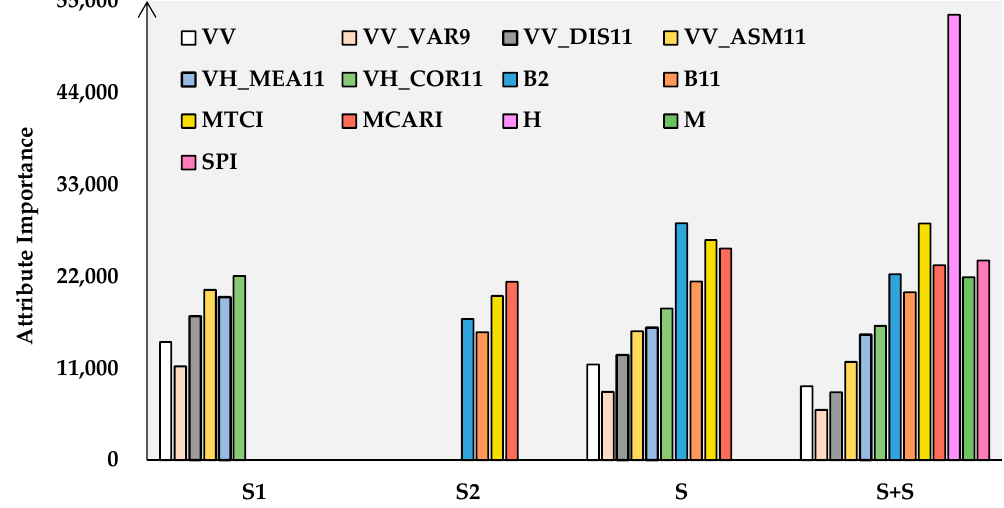
Figure 4. The attribute importance based on the average impurity decrease for the four RF models.